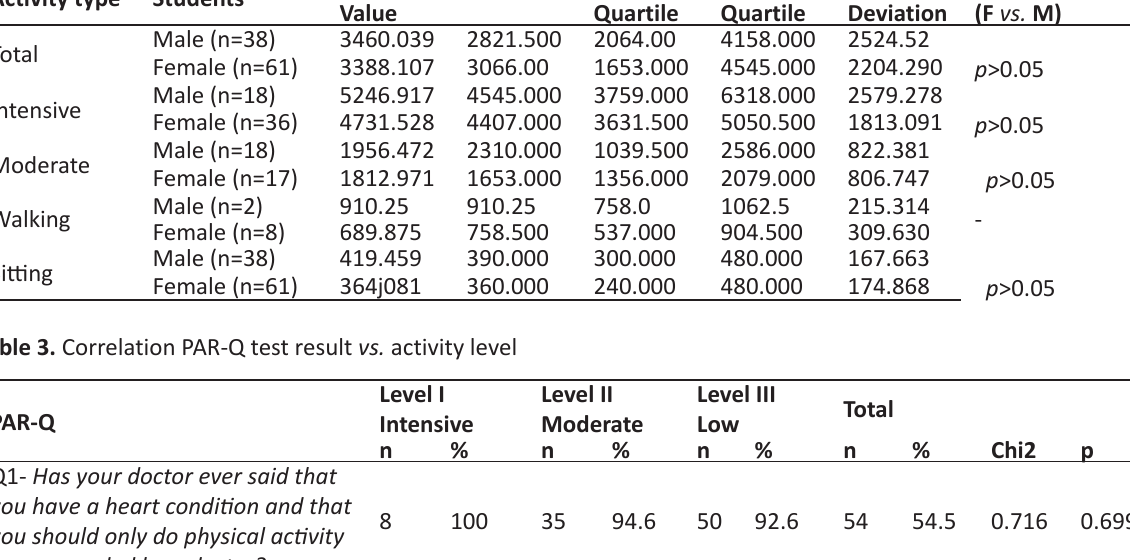
Table 2. Level of physical activity of male (n=38) and female students (n=61) Activity type